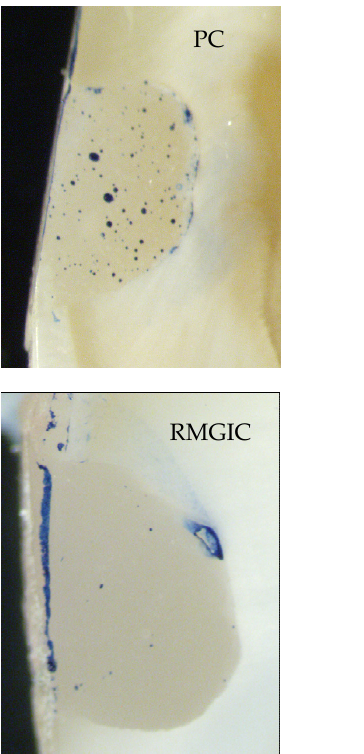
Figure 3. Pictures of sectioned specimens from all groups (1 – 4) showing microgaps at the restoration – tooth interface.